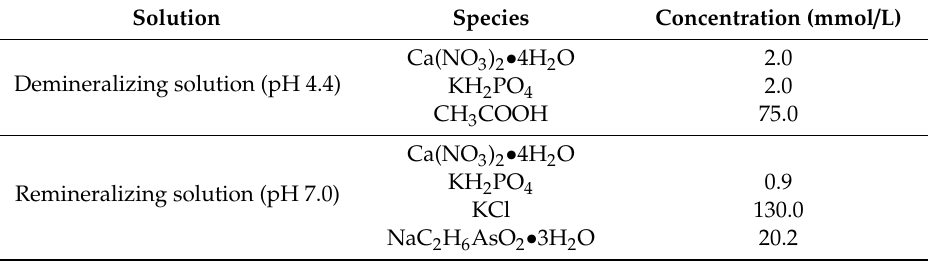
Figure 1. Remineralization length analysis. ( a ) Micro-CT slice of the region of interest at the center of the lesion perpendicular to the enamel surface; the remineralization length is indicated by the yellow line, D indicates dentin, E indicates enamel, and R indicates the resin sample. ( b ) Plot of brightness versus distance from the resin prepared using ImageJ; the pink arrow indicates 87% brightness relative to the reference point and the blue arrow indicates the remineralization length. Table 1. Composition of the demineralizing and remineralizing solutions.